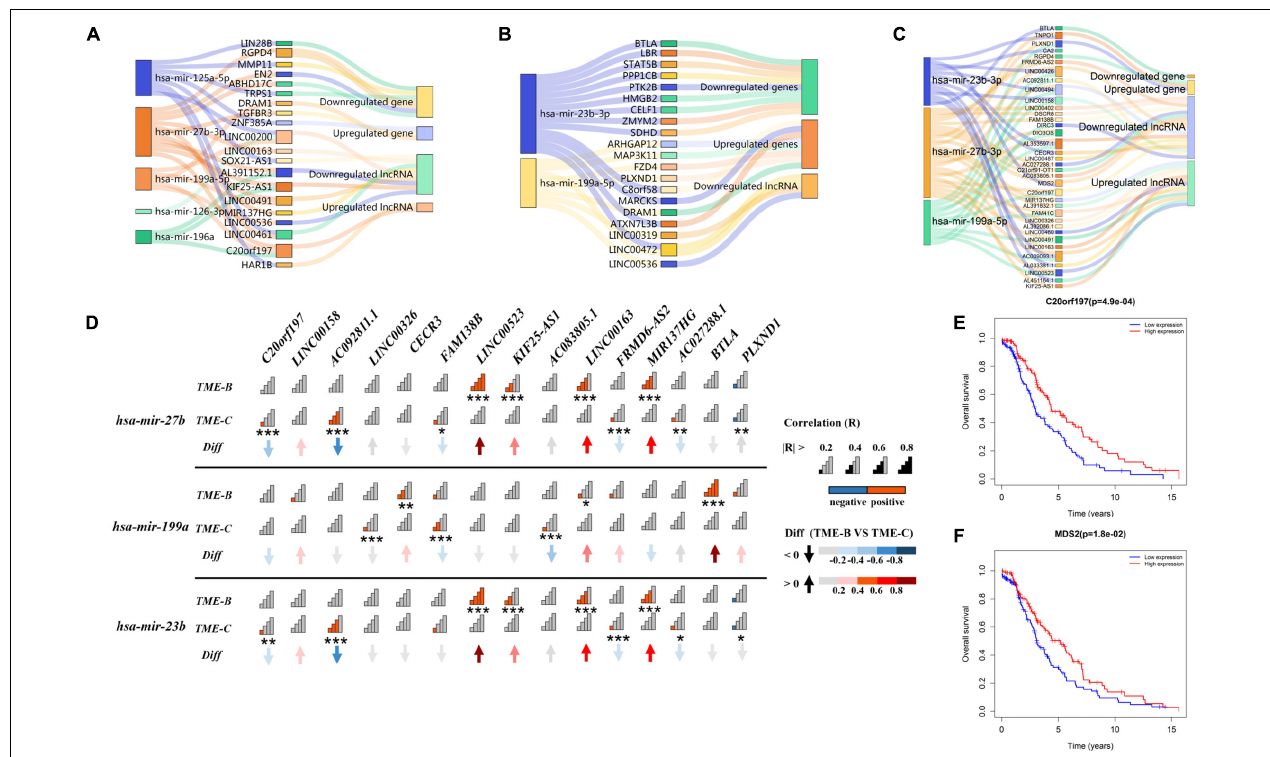
FIGURE 7 | The Sankey plot of the endogenous competitive network in three TME groups. The rectangle size of miRNA represents the number of DEGs and lncRNAs. Panel (A) represents the ceRNA network of differentially expressed miRNA, lncRNA, and genes in the TME-A versus TME-B. Panel (B) represents the ceRNA network of differentially expressed miRNA, lncRNA, and genes in the TME-A versus TME-C. Panel (C) represents the ceRNA network of differentially expressed miRNA, lncRNA, and genes in the TME-B versus TME-C. Panel (D) represents the correlation of differentially expressed miRNA and lncRNAs between TME-B and TME-C. The “Diff” is defined as the differential correlation in TME-B versus TME-C. Signal plot shows the degree of correlation. The P value is labeled with asterisks below signal plot (*** P < 0.001, ** P < 0.01, * P < 0.05). (E,F) The Kaplan–Meier survival analysis for differentially expressed lncRNAs in TME-B versus TME-C. Red (blue) line represents the survival probability of patients with sarcomas when the expression level of RNAs is high